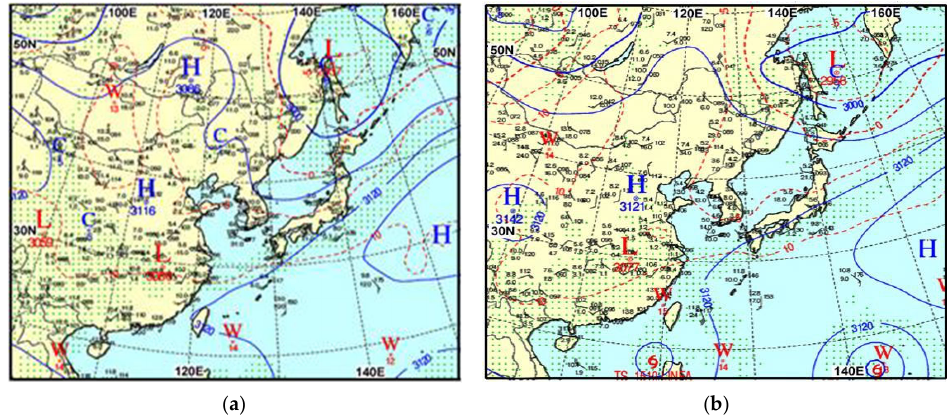
Figure 5. ( a ) Geopotential analysis (m) at 700 hPa (approximately 3 km height) at 09:00 LST, 4 July 2015, and ( b ) 09:00 LST, 6 July 2015. The distribution of small green ‐ colored dots (clouds) oriented southwest to northeast through southern China indicate the MLCT located between a low pressure in the north and the North Pacific Ocean High Pressure (H) on the right in ( a ) and ( b ). Thus, clouds cover from 1.5 to 3 km in height.